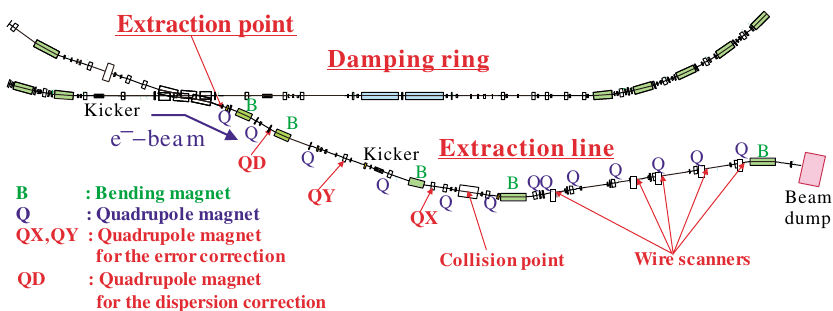
FIG. 3. (Color) Extraction beam line of the damping ring. Bending and quadrupole magnets are indicated.